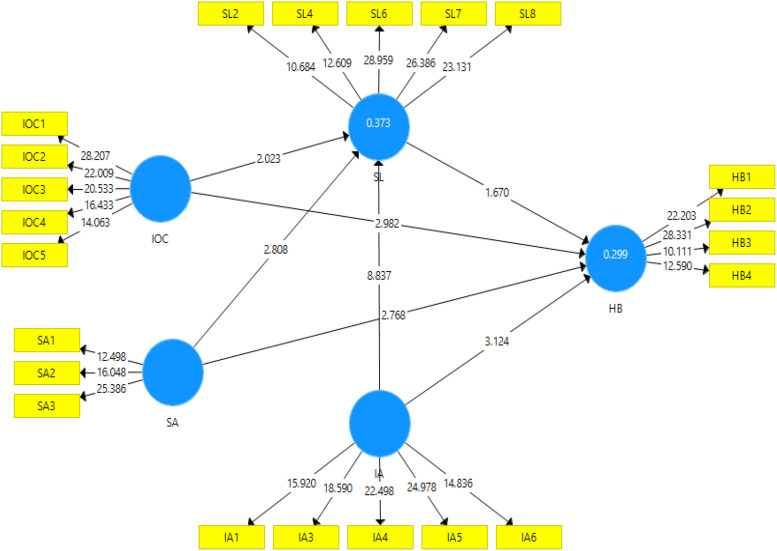
Structural model.